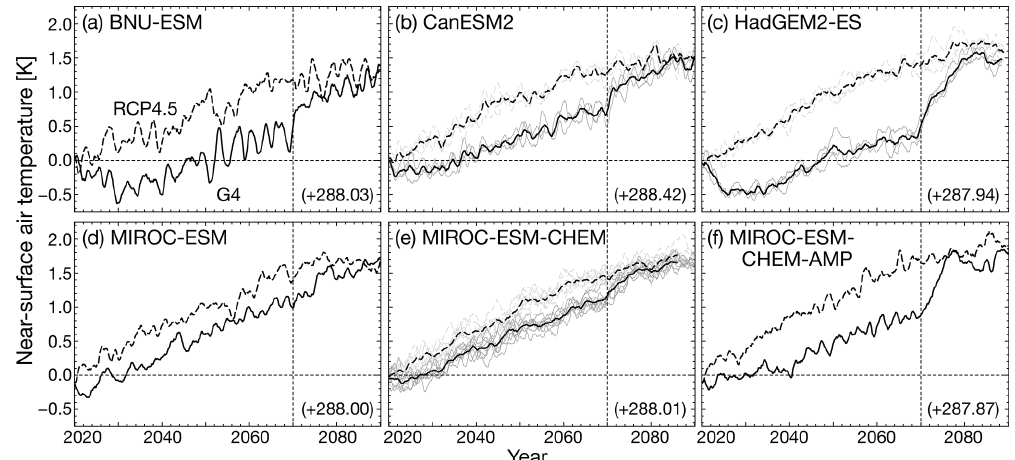
Figure 2. Globally averaged surface air temperature in G4 (solid) and RCP4.5 (dashed) experiments. 12-month running mean is applied. Values are offset by the RCP4.5 average from 2018 to 2022, the beginning of SRM, shown at the right bottom on each panel. In (b) , (c) , and (e) , black curves show the ensemble mean and grey curves show ensemble members. The vertical dashed lines indicate the SRM termination (2070).